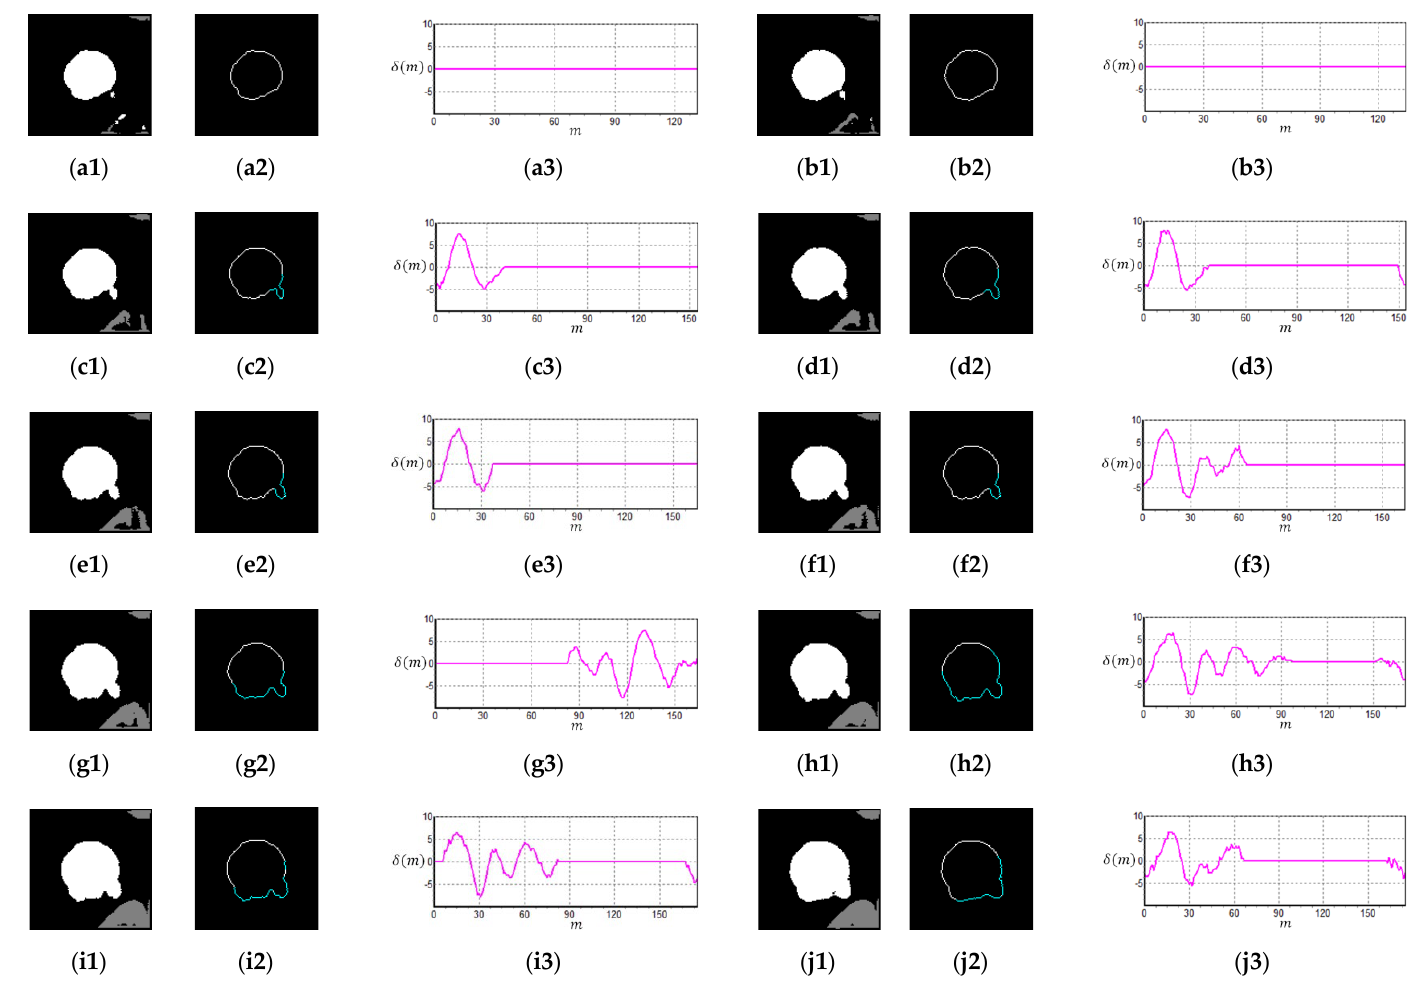
Figure 15. Micronucleus detection of Figure 4a (k = 15, 15th layer is background): ( a1 – j1 ) cell nuclei regions (3rd–12th color layer regions); ( a2 – j2 ) contours of regions; ( a3 – j3 ) short window energy curve according to screening sensitivity ( µ =